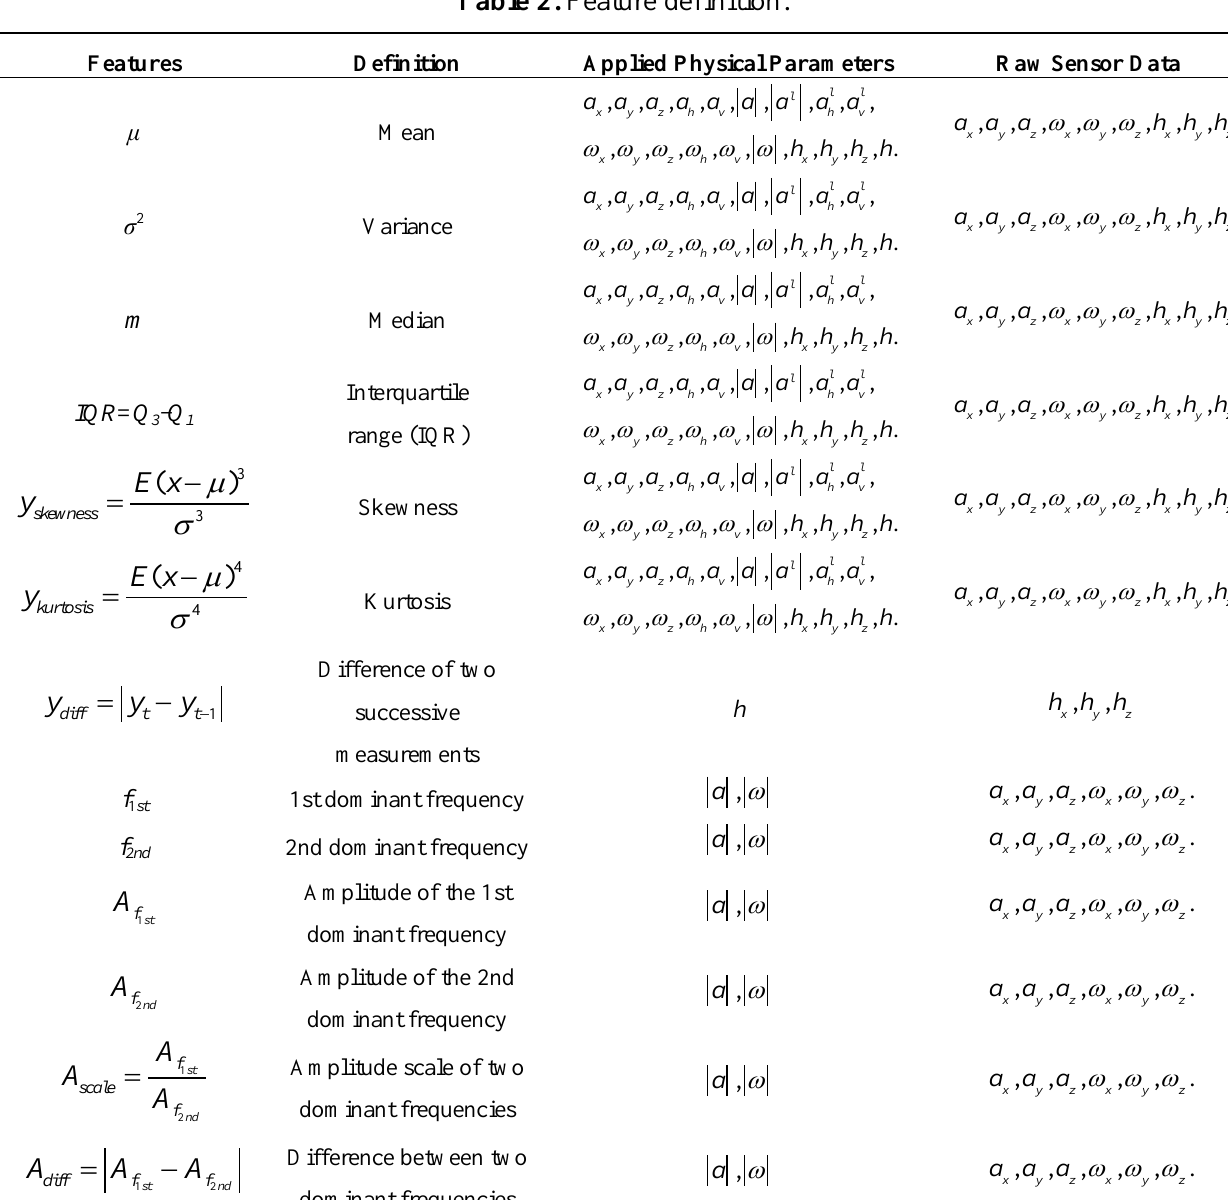
Table 2. Feature